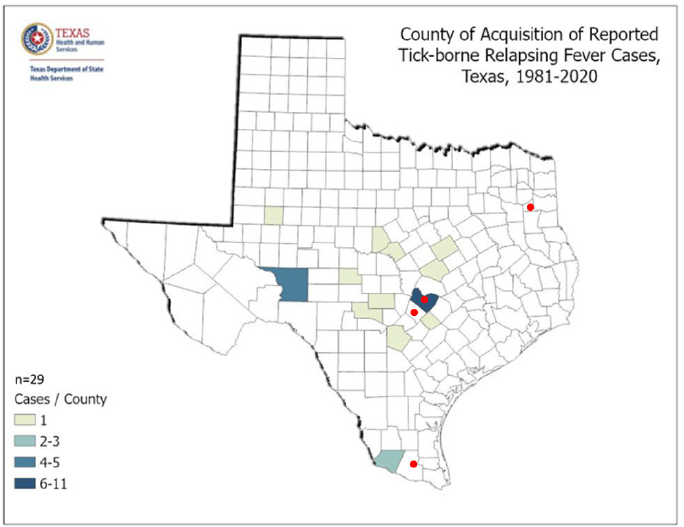
Figure 9. Map of DSHS locally acquired spotted fever rickettsiosis by respondents with most severe symptoms [22]